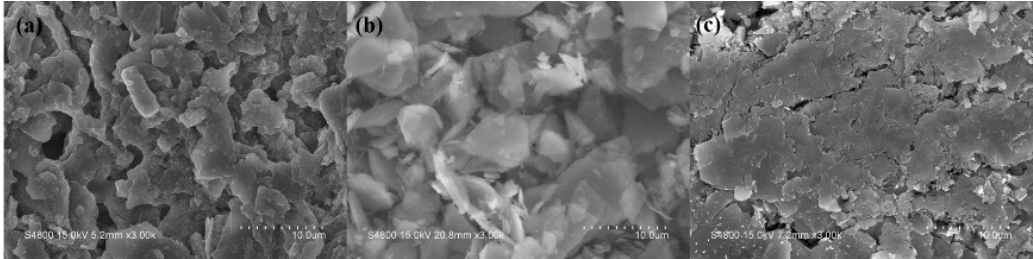
Figure 6. Surface morphologies of the residues after cone calorimetry at a flux of 35 kW m − 2 . ( a ) EVA1; ( b ) EVA2; ( c ) EVA5.